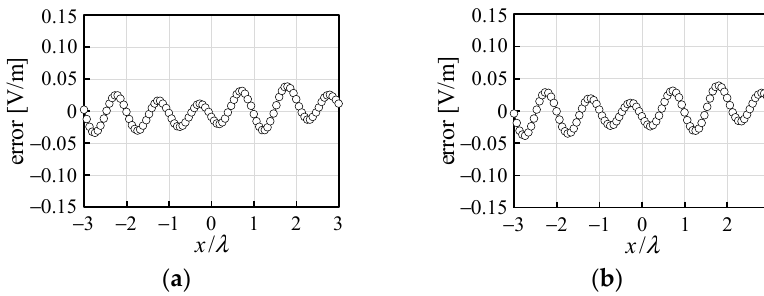
Figure 10. Error of incident field on x -axis ( M = 200): ( a ) square target and ( b ) L-shape target.